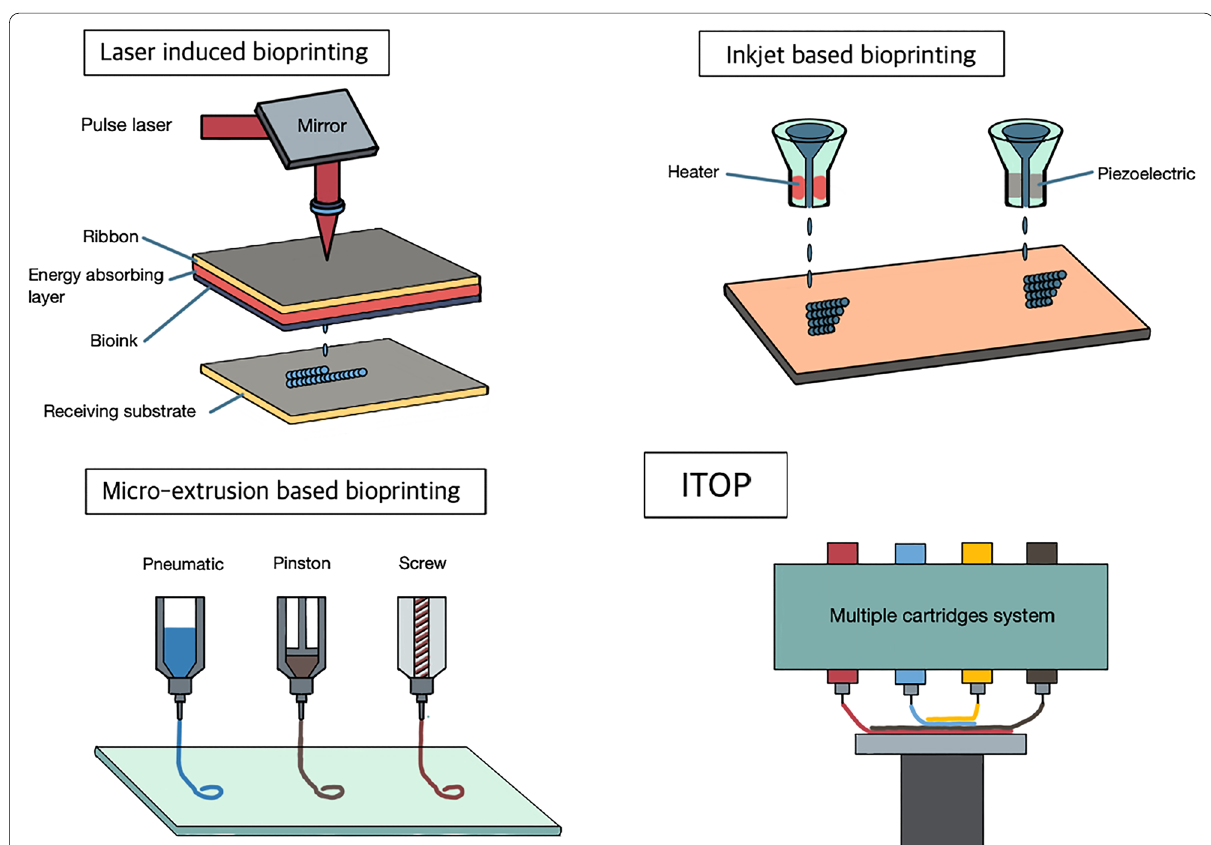
Fig. 2 Bio‑printing modalities, the primary bio‑printing methods include laser‑induced bio‑printing (LIB), inkjet‑based bio‑printing (IBB), and micro‑extrusion‑based bio‑printing (EBB) according to their performance modalities. In addition, integrated tissue and organ printing (ITOP) system, equipped with multiple cartridges can print composite tissue at one